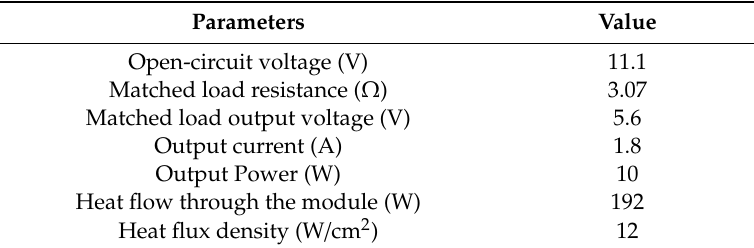
Figure 3. Diagram of experimental system. Table 2. Specific parameters of the thermoelectric generator (TEG) chip.